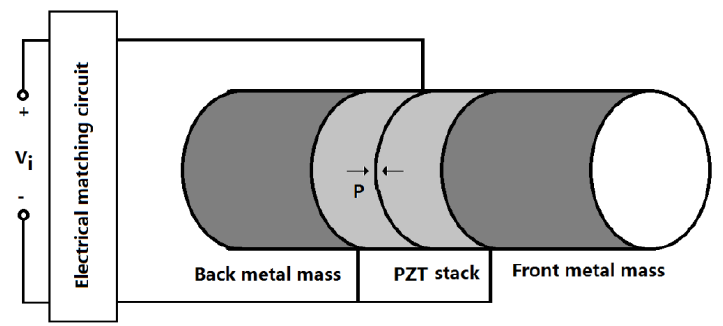
Figure 2. A high power sandwiched piezoelectric transducer with matching circuit.